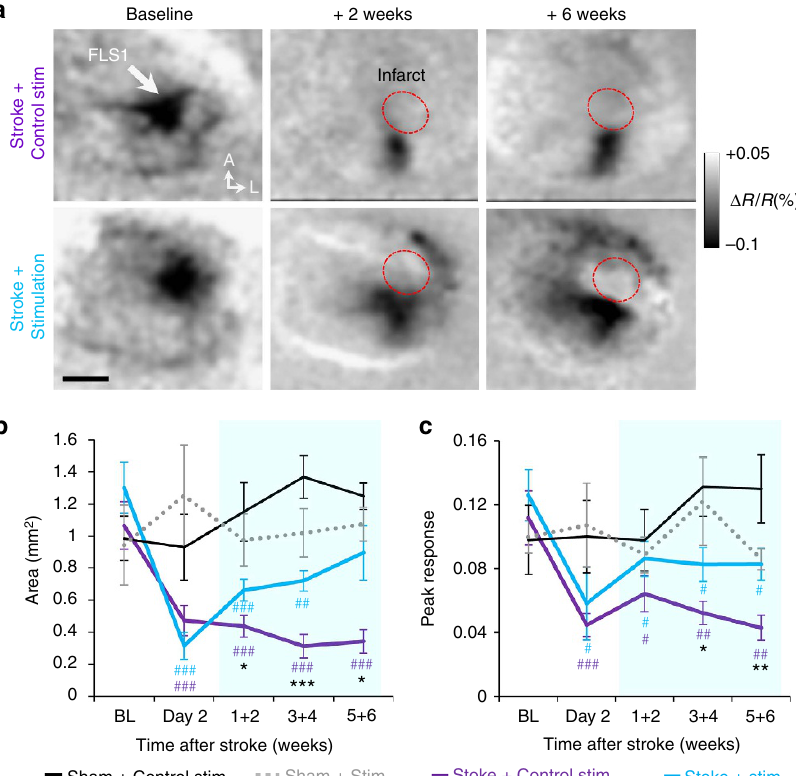
Figure 6 | Optogenetic stimulation enhances recovery of sensory cortical circuits. ( a ) Time lapse IOS images showing the primary somatosensory cortical response (darkened area) to stimulation of the contralateral forepaw (100Hz for 1s). Red circle denotes infarct area. Grey levels in each image reflect percent changes in light reflectance averaged over 0.5–1.5s after forelimb stimulation relative to BL. ( b ) Graph plotting the area of cortical territory activated by forelimb stimulation in sham stroke controls (Control stimulation: n ¼ 5 mice; ChR2 stimulation: n ¼ 7 mice) or mice with stroke that received control or optogenetic stimulated mice (Control stimulation: n ¼ 11 mice; ChR2 stimulation: n ¼ 10 mice). ( c ) Graph plotting peak cortical responses (absolute value of % D R / R ) to forelimb stimulation. Data are means ± s.e.m. # P o 0.05, ## P o 0.01, ### P o 0.001 based on t -tests comparing post-stroke time points in each group designated by colour to respective BL values. * P o 0.05, ** P o 0.01, *** P o 0.001 based on t -tests comparing stroke þ stimulation versus stroke þ control stimulation. Scale bar, ( a )